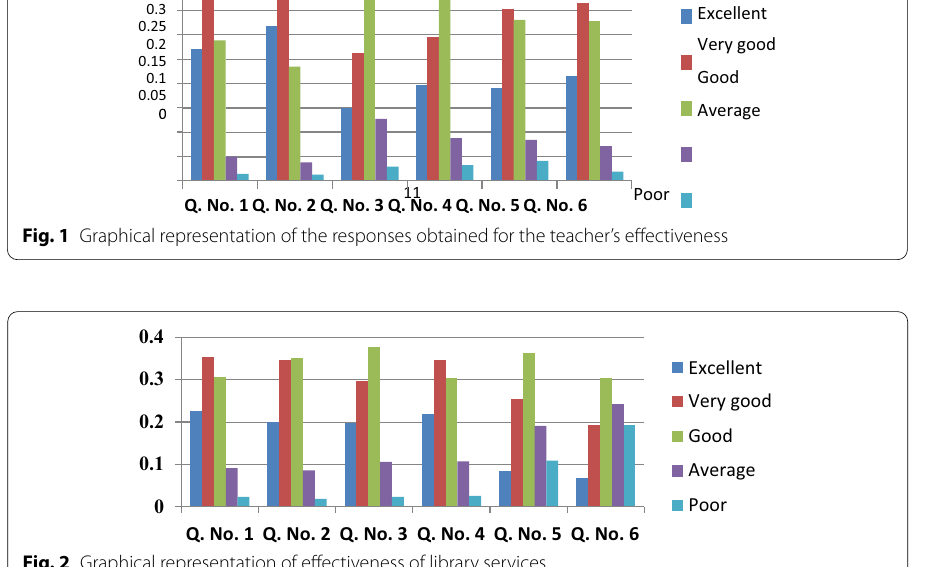
SUPPORT FOR CULTURAL ACTIVITIES